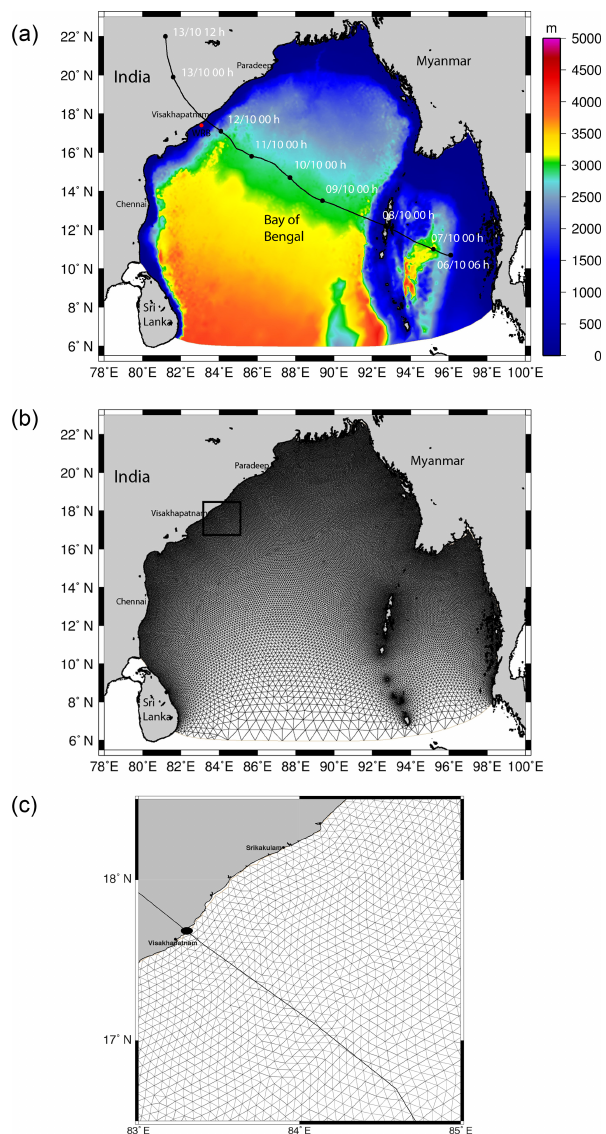
Figure 1. (a) Bathymetry of the model domain chosen for wave– current interaction during Hudhud cyclone; cyclone track details are shown, and the red dot represents the wave rider buoy location. (b) Fine-resolution unstructured mesh generated for the domain to run the coupled ADCIRC + SWAN model; rectangular box represents the region where measured data are available for model validation (details of the box is shown in c ). (c) Fine-resolution mesh of the box shown in (b) ; black circle is the landfall point of the Hudhud cyclone, and the cyclone track is also